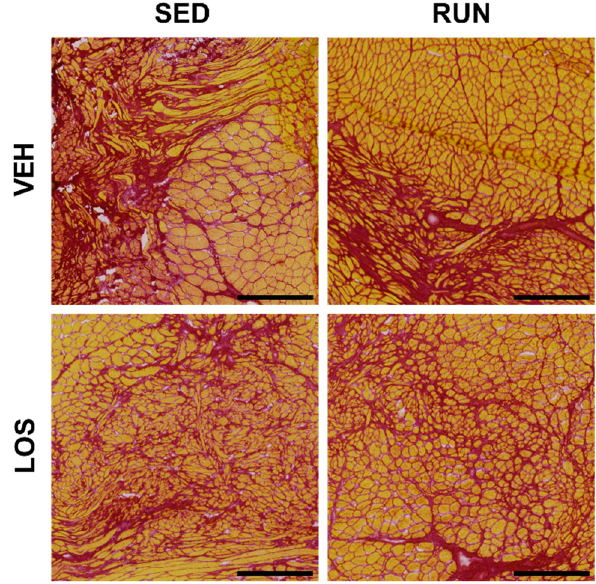
Figure 5. Qualitative evaluation of fibrosis via picrosirius red staining in VML-injured limbs at 56 DPI. Excessive collagen content (red stain) was observed in the defect region of the VML, indicating excessive fibrosis development in and around the site of injury for all experimental groups. Scale bars = 500 µm.